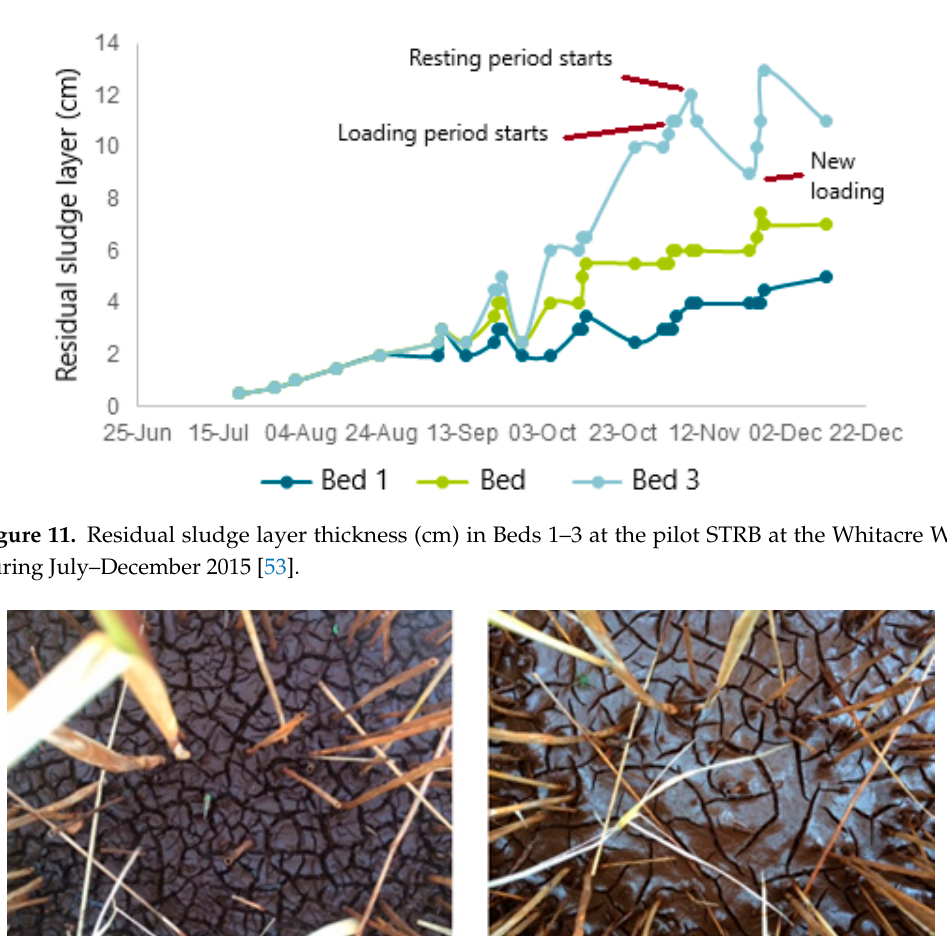
Figure 11. Residual sludge layer thickness (cm) in Beds 1–3 at the pilot STRB at the Whitacre WW during July–December 2015 [53].